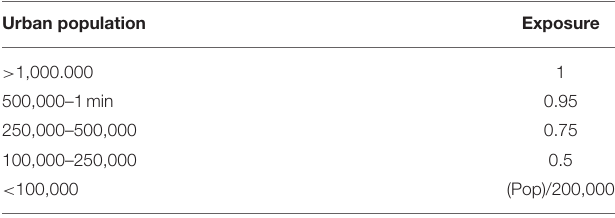
TABLE 3 | Weighting of the Urban Population variable, which defines the Exposure